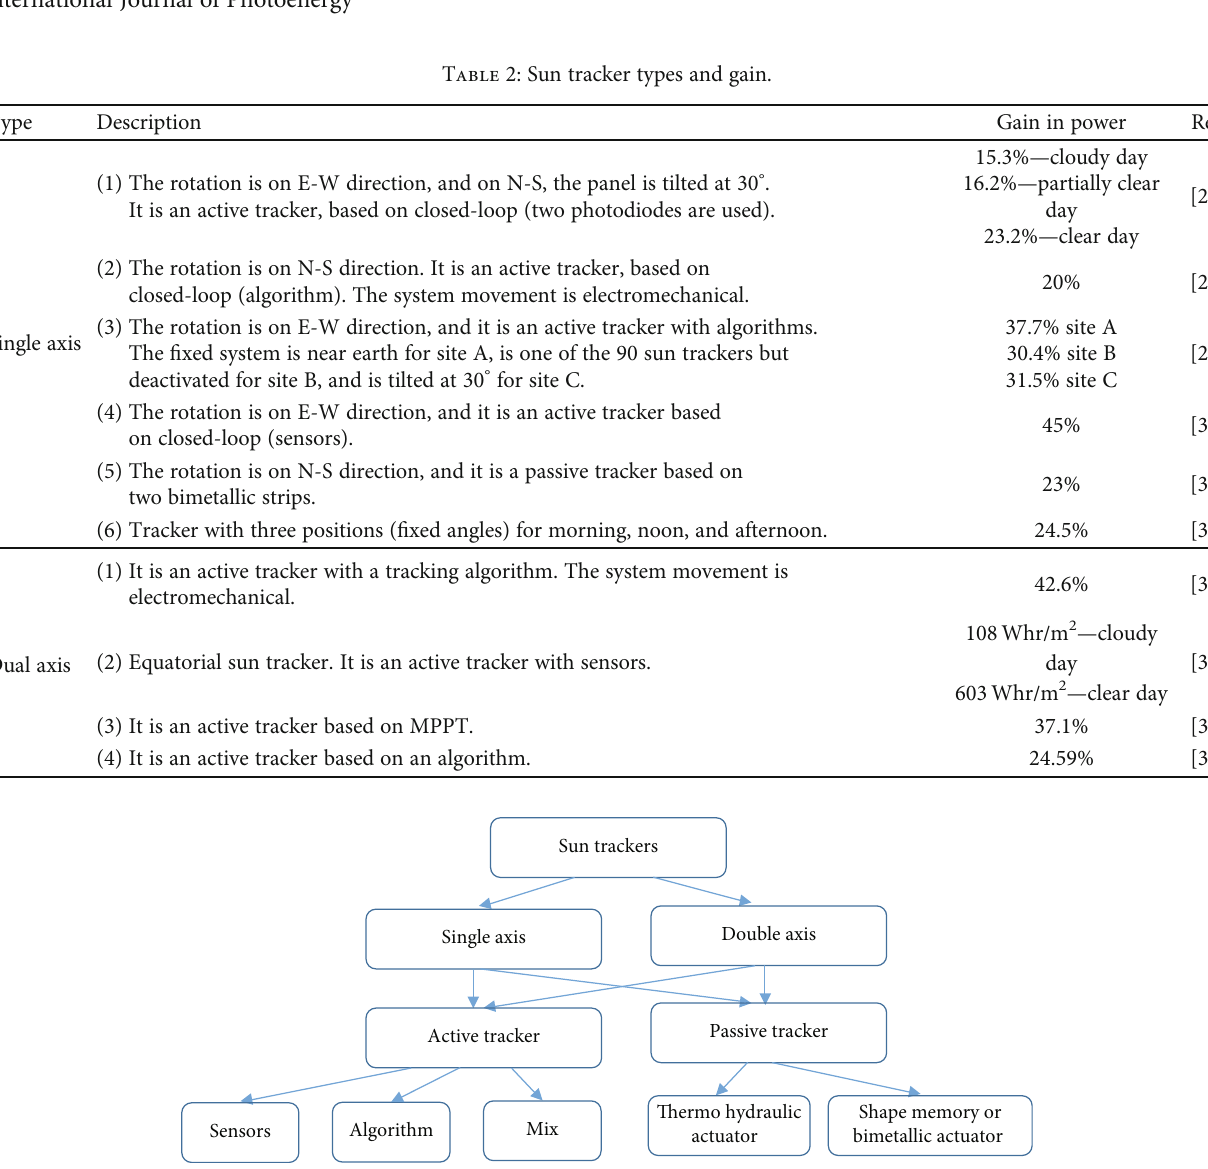
Figure 3. The comparison is made for di ff erent solar global radiation values from 100W/m 2 to 1000W/m 2 , measured with a pyranometer placed in the same plane with the PV panels on a clear day. The gain in percentages for the maxi- mum power of the PV panel with EPR varies from 8% at 100W/m 2 irradiance to 17% at 1000W/m 2 irradiance. The gain in power, function of the irradiance, is linear (Figure 4).